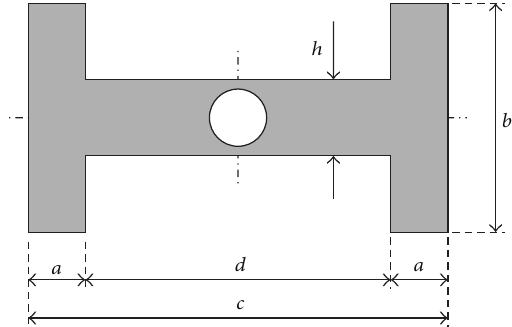
Figure 2: Parameters that define the geometry of a typical H